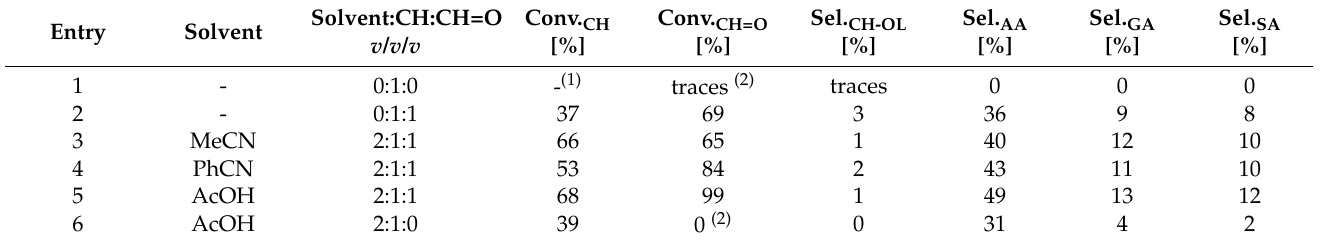
Table 1. The influence of the solvent on the oxidation of CH/CH=O mixture.